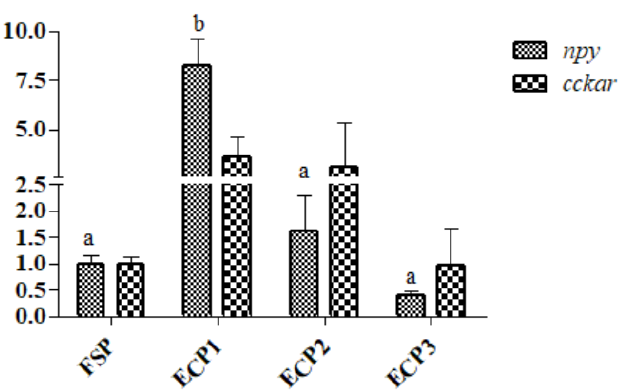
Figure 6. Effect of fish soluble pulp and enzymatic chicken pulp on the expression of npy and cckar on mRNA gene in the hepatopancreas of L. vannamei . npy —Neuropeptide Y, cckar —cholecystokinin receptor type A-like. Means without superscripts or with the same superscripts do not differ significantly ( p > 0.05), while those with different superscripts differ significantly ( p < 0.05).